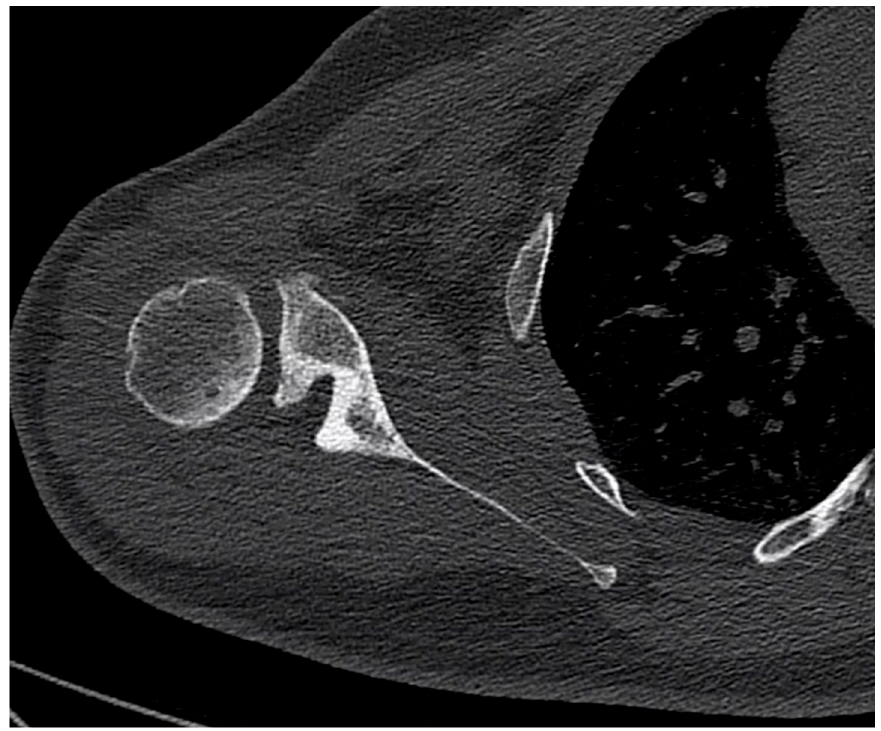
Figure 1. Example of a right B2 glenoid. Observe the biconcave glenoid and the posterior subluxation of the humeral head.